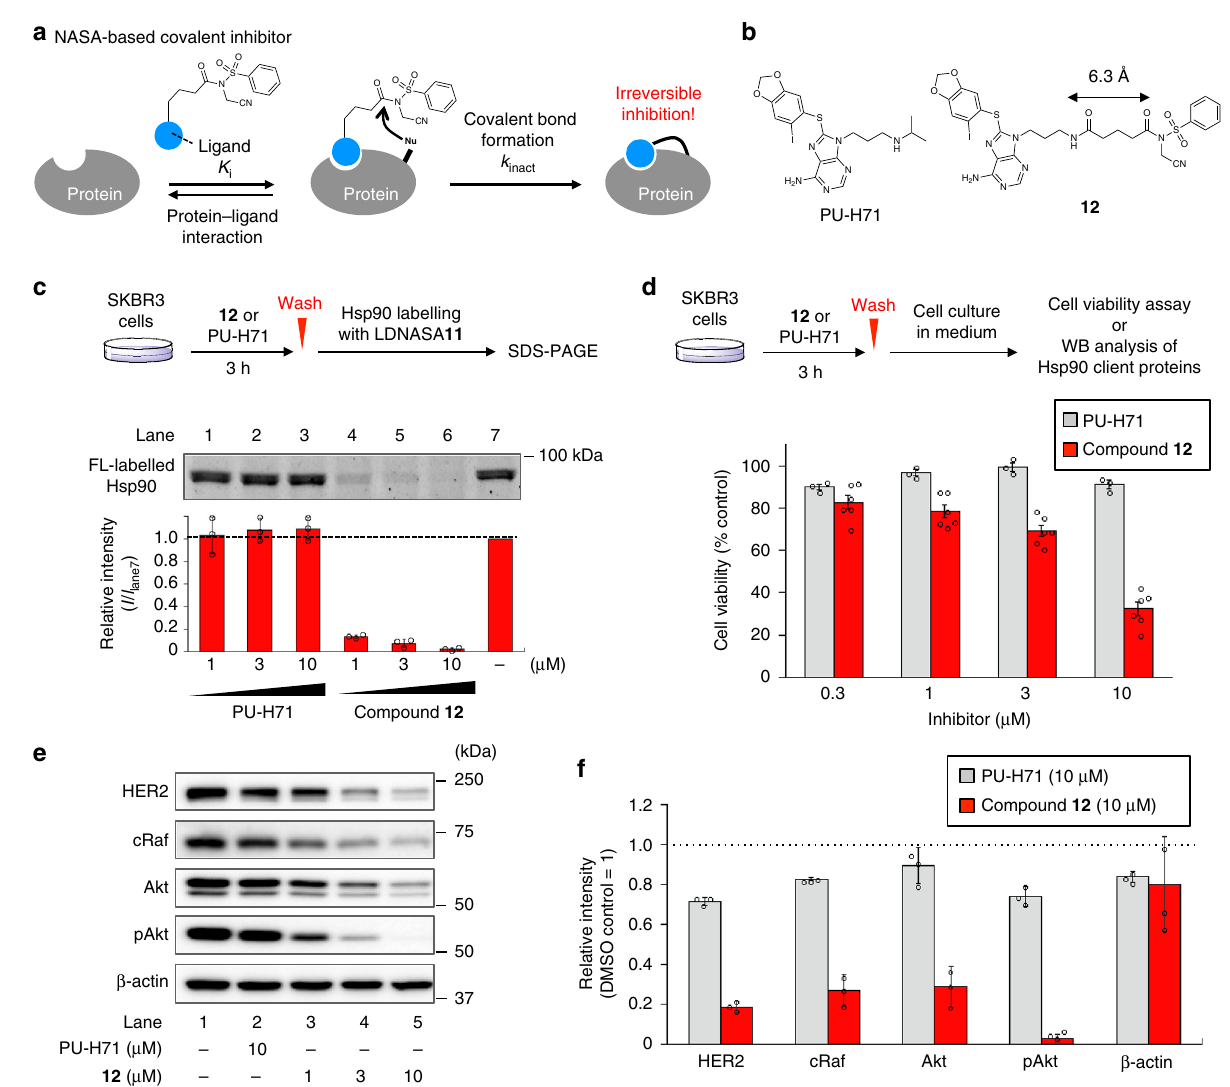
Fig. 6 Irreversible inhibition of intracellular Hsp90. a Schematic illustration of reaction mechanism of NASA-based covalent inhibitor. b Molecular structures of PU-H71 (non-covalent inhibitor) and NASA-based covalent inhibitor 12 . c In-gel fl uorescence analysis of fl uorescein labelling of Hsp90 with 11 in SKBR3 cells after inhibitor washout. After cells were incubated with various concentrations of PU-H71 or 12 for 3 h, the cells were washed with medium and further incubated with 11 for 3 h. The cells were washed, lysed and analysed by in-gel fl uorescence imaging. Error bars represent s.d., n = 3. d Viability of the cells 69 h after PU-H71 or 12 washout. Data represent mean values± standard error of the mean (s.e.m.) for three (PU-H71) or six (compound 12 ) independent experiments. e Western blotting analysis of the destabilization of client proteins induced by inhibiting Hsp90 chaperone activity, and f the normalised band intensities. Cells were treated with PU-H71 or 12 for 3 h, followed by washing with media and further incubation for 21 h. The protein band intensity was normalised to DMSO control (lane 1). β -actin is a control as a non-Hsp90 client protein. Error bars represent s.d., n =